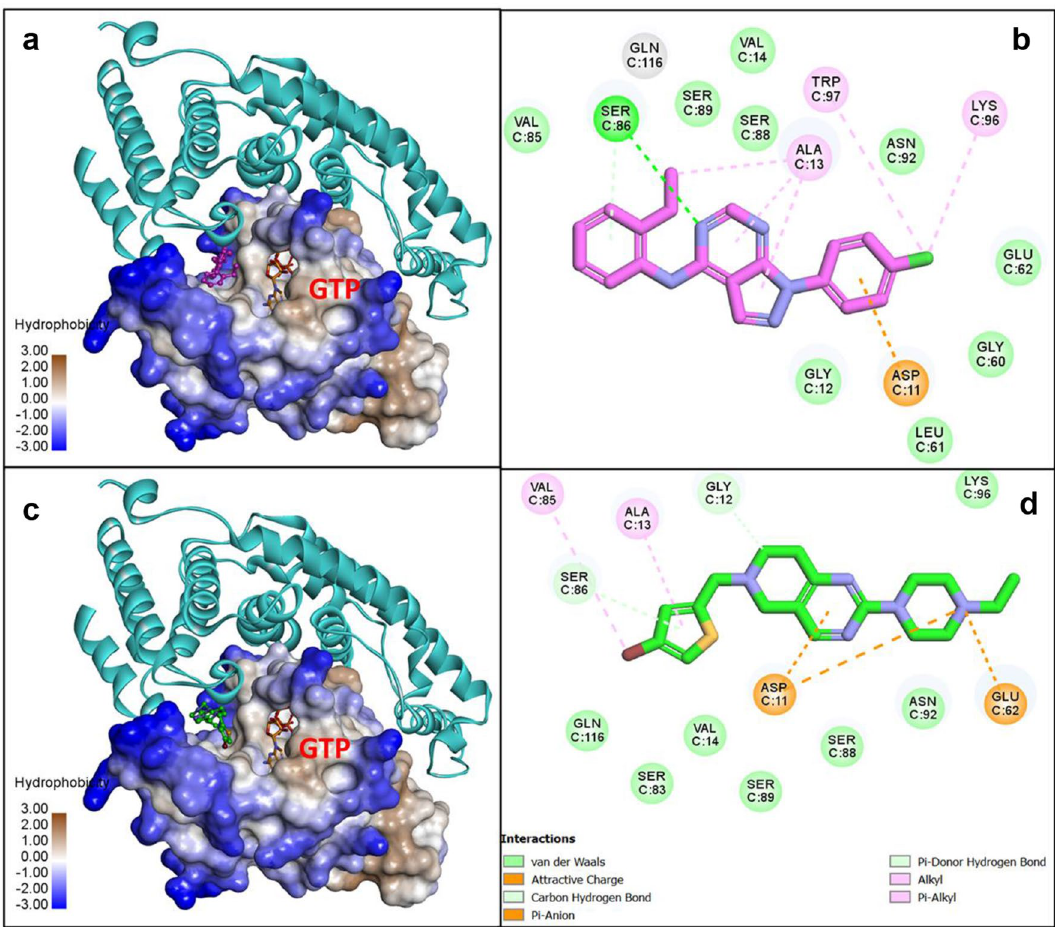
Figure 7. Predicted binding models of NCGC00138812 ( a , b ) and NCGC00131308 ( c and d ) bound to Cdc42 at the protein-protein interaction interface with IQGAP1. Cdc42 is shown in hydrophobic surface representation and IQGAP1 is shown as ribbons in cyan ( a , c ). GTP bound in Cdc42 is shown as sticks. 2D diagrams of binding interactions between Cdc42 and small molecule inhibitors are depicted in panels ( b , d ). The compounds are shown as sticks with carbon atoms in purple (NCGC00138812) and green (NCGC00131308). N and O atoms are colored blue and red, respectively. The figure was generated using the free open access software Discovery Studio Visualizer (https:// disco ver. 3ds. com/ disco very- studio- visua lizer- downl